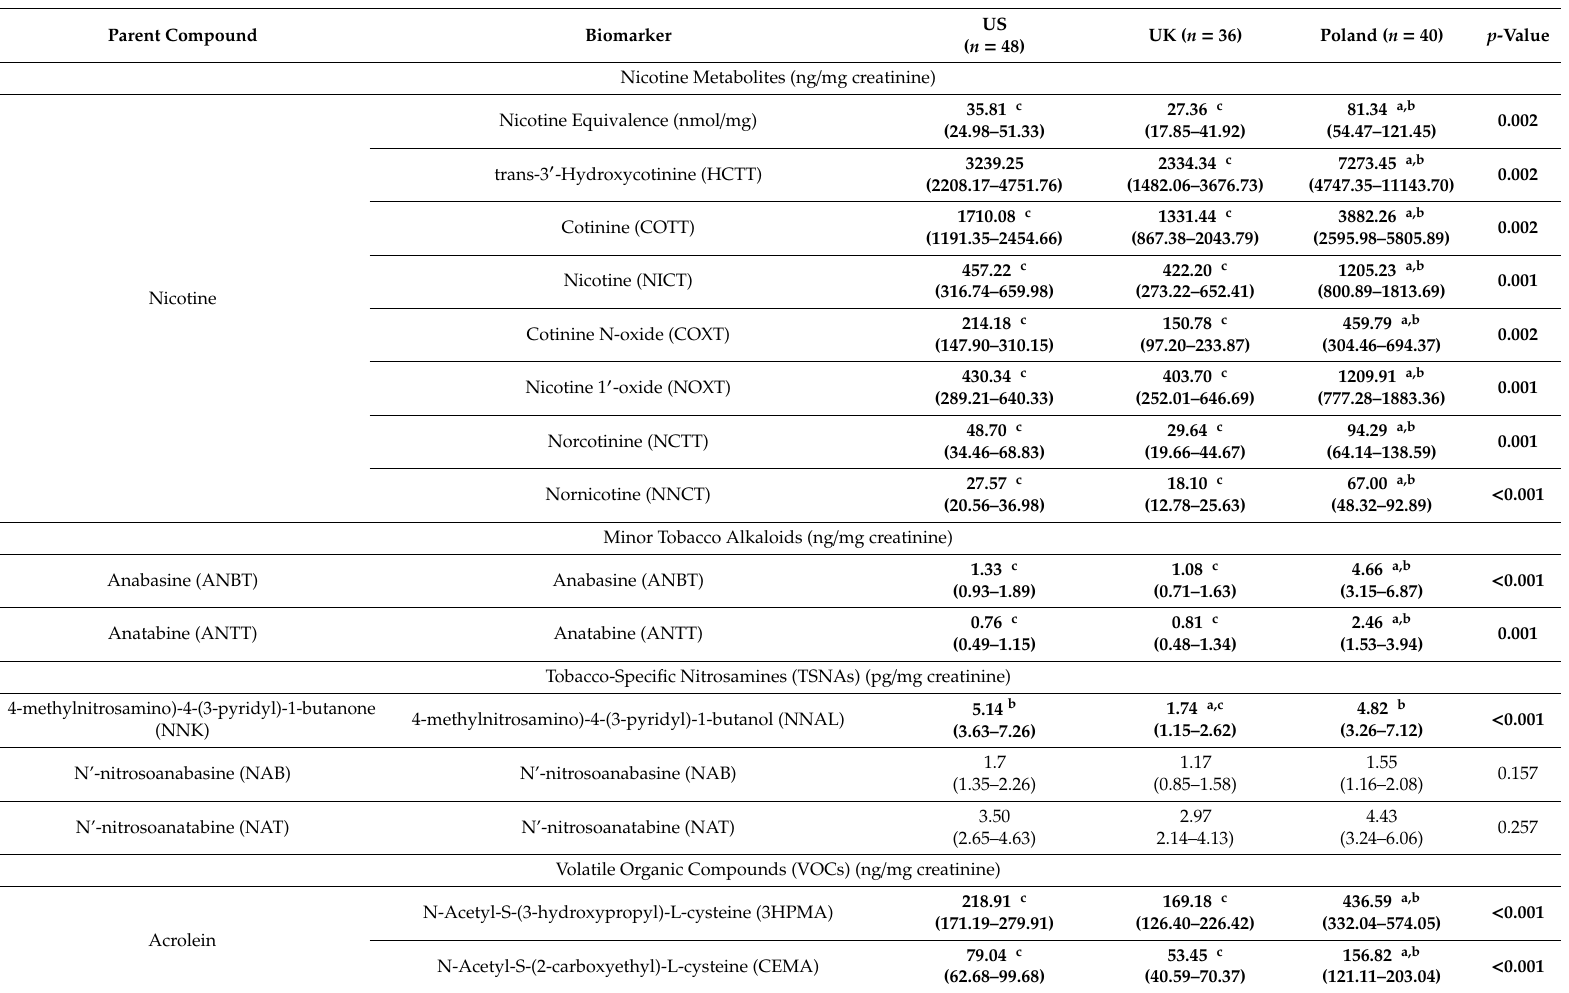
Table 2. Biomarkers of exposure to nicotine and selected toxicants in urine of exclusive E-cigarette users ( n = 124) from US, UK and Poland (normalized for creatinine; geometric means, 95% confidence